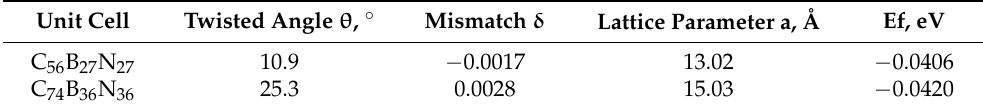
Figure 1. Molecular bonded twisted G/BN bilayers: ( a ) dependence of number of atoms per supercell on twist angle θ (gray circles—number of carbons, red squares—sum of boron and nitrogen atoms); ( b ) top view of the atomic structures with θ = 30° ± 4.7° (gray, red and blue balls denote carbon, boron and nitrogen atoms, respectively). Table 1. Parameters of the considered G/BN